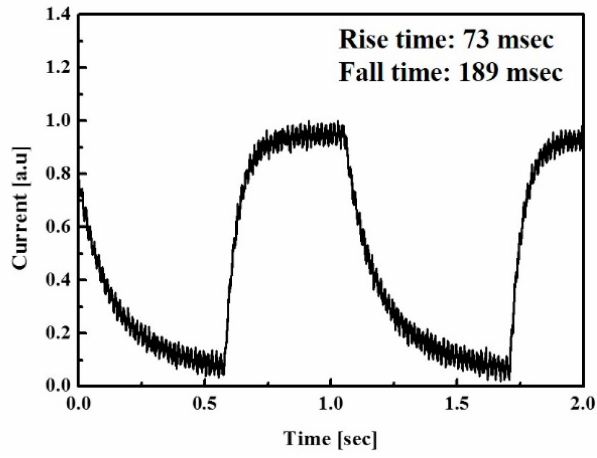
Figure 10. Transient photo response waveform of optimized UV photodetector with ´ 1 V